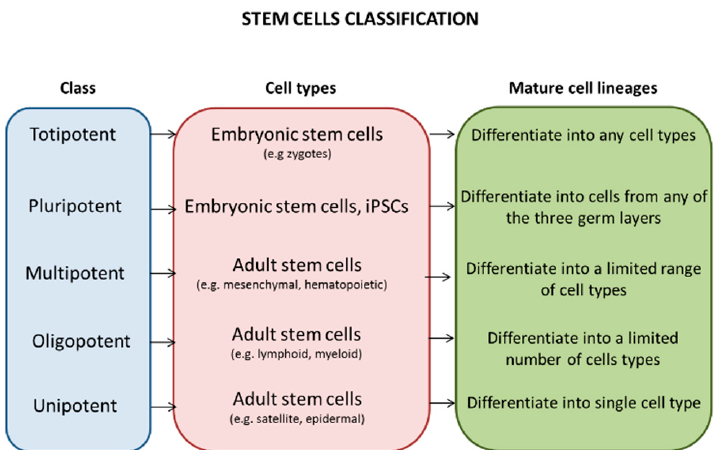
Figure 1. Classification of stem cells. Stem cells can be classified according to their plasticity in: Totipotent that give rise to all embryonic and extraembryonic cell lines; pluripotent that can produce all embryonic cell types; multipotent that differentiate to a great number of cell types; oligopotent that have the ability to differentiate into only a few cell lineages; and unipotent that give rise to only one specific cell type.